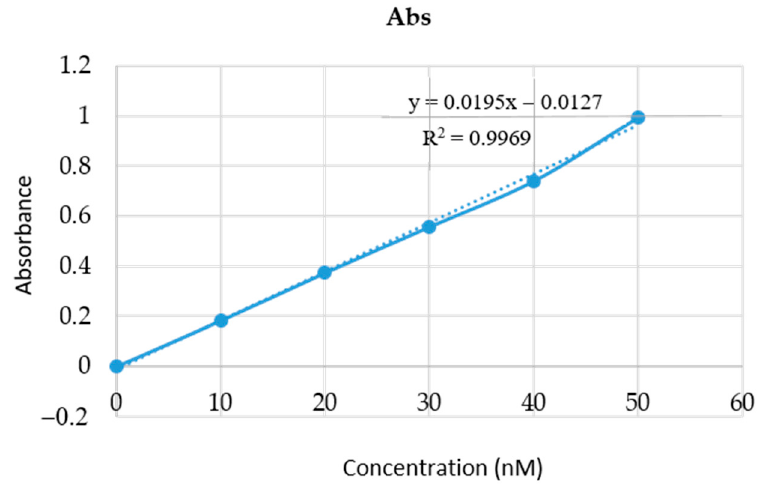
Figure 7. Absorption observed at different concentrations of nanoemulgel.